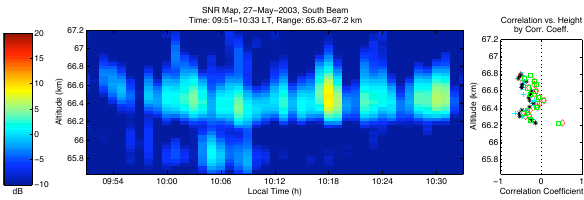
Fig. 11. A thin sheet at 66.5km on 27 May at 9:50 LT. Fig. 12. A thin sheet at 69.6 km on May 28 at 10:40 LT. Fig. 14. A thin sheet at 64 km on July 14, 2004, at 13:15 LT.